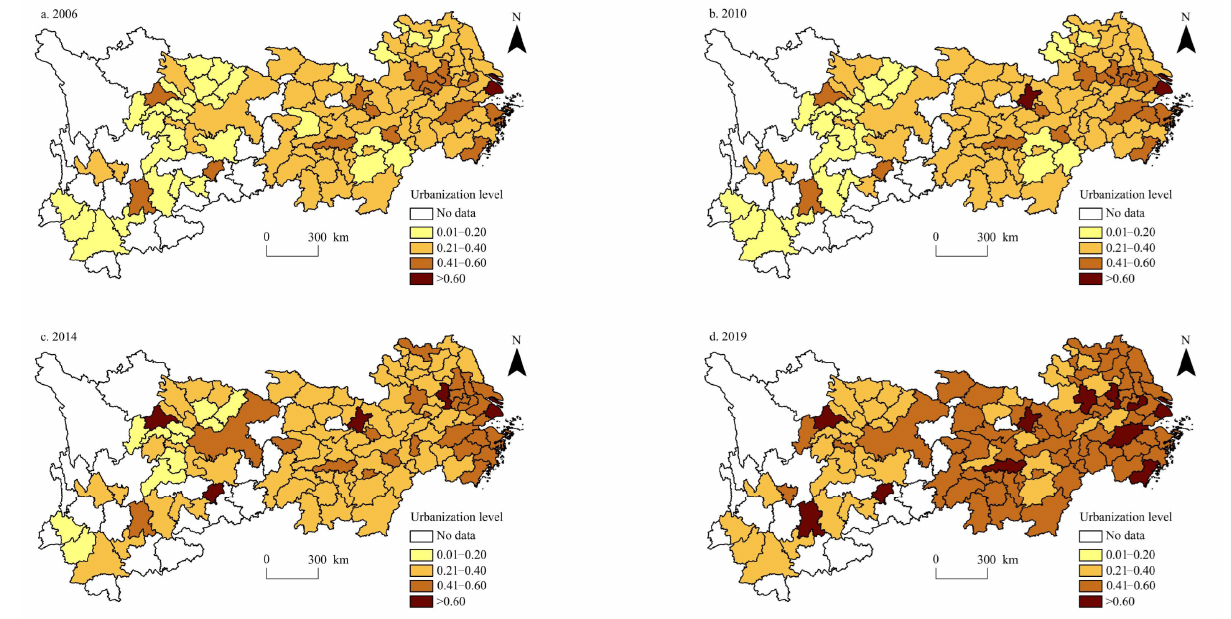
Figure 3. Spatial distribution pattern of urbanisation level in the Yangtze River Economic Belt during 2006–2019.